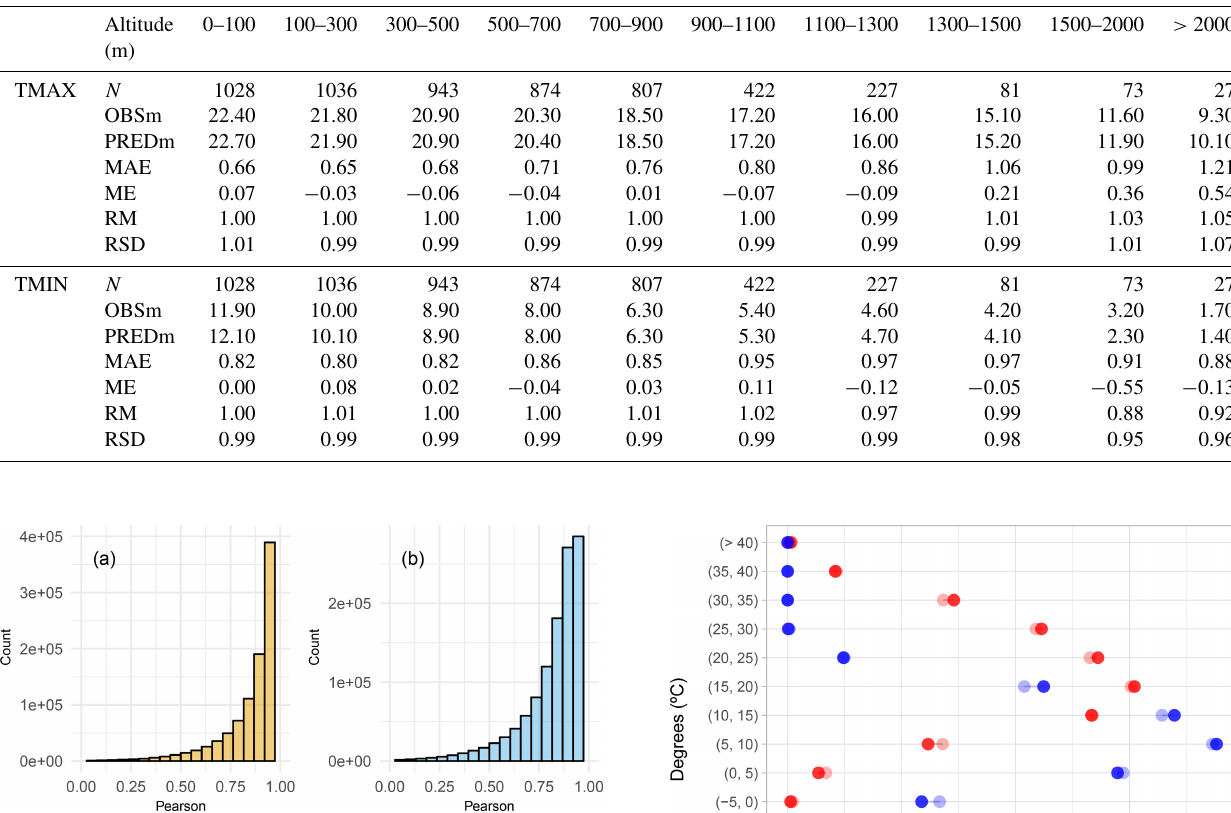
Table 3. The leave-one-out cross-validation (LOO-CV) statistics showing the goodness of fit between observations and estimates of daily maximum and minimum temperature separated by altitudes (ma.s.l.). N : number of stations; OBSm: mean observed temperature ( ◦ C); PREDm: mean predicted temperature ( ◦ C); MAE: mean absolute error ( ◦ C); ME: mean error ( ◦ C); RM: ratio of means; RSD: ratio of standard deviations. Results were constrained to two decimal digits.